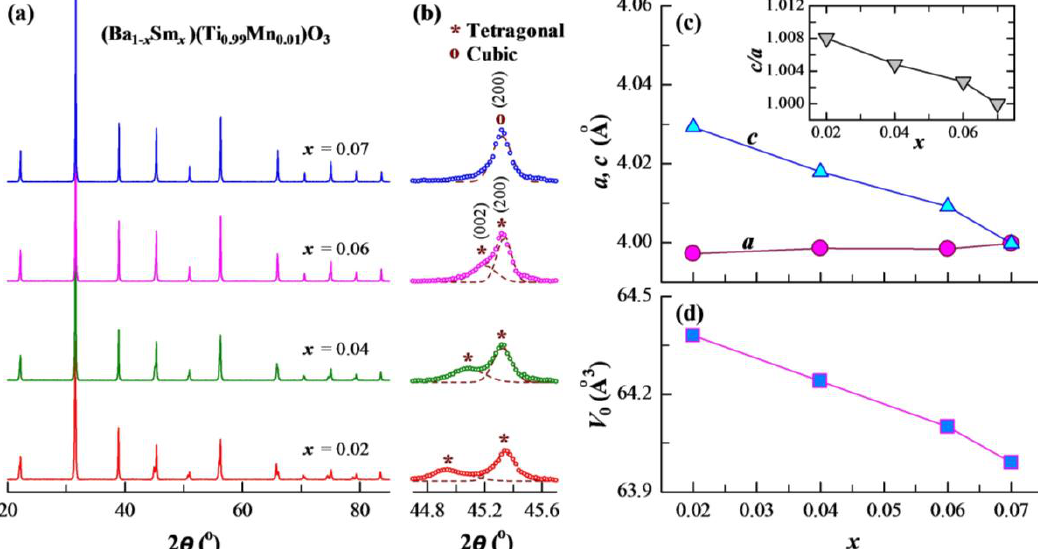
Figure 2. ( a ) Powder XRD patterns of BSTM ceramics. ( b ) Enlarged peaks in the vicinity of 45°; the dashed lines denote Gaussian fits of the peaks. ( c ) Lattice parameters ( a , c ) and ( d ) unit cell volume ( V 0 ) as a function of x . The inset depicts the tetragonality ( c / a ) as a function of x .